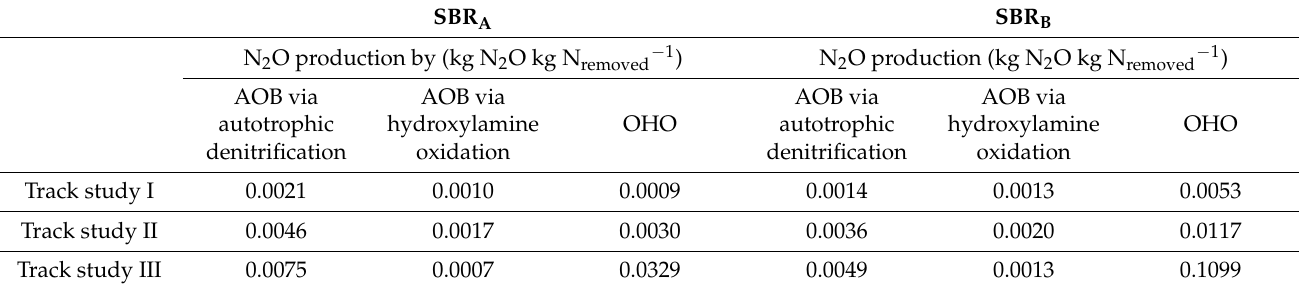
Table 8. N 2 O production in SBR A and SBR B by AOB (via autotrophic denitrification), AOB (via hydroxylamine oxidation) and OHO. SBR A SBR B N 2 O production by (kg N 2 O kg N removed − 1